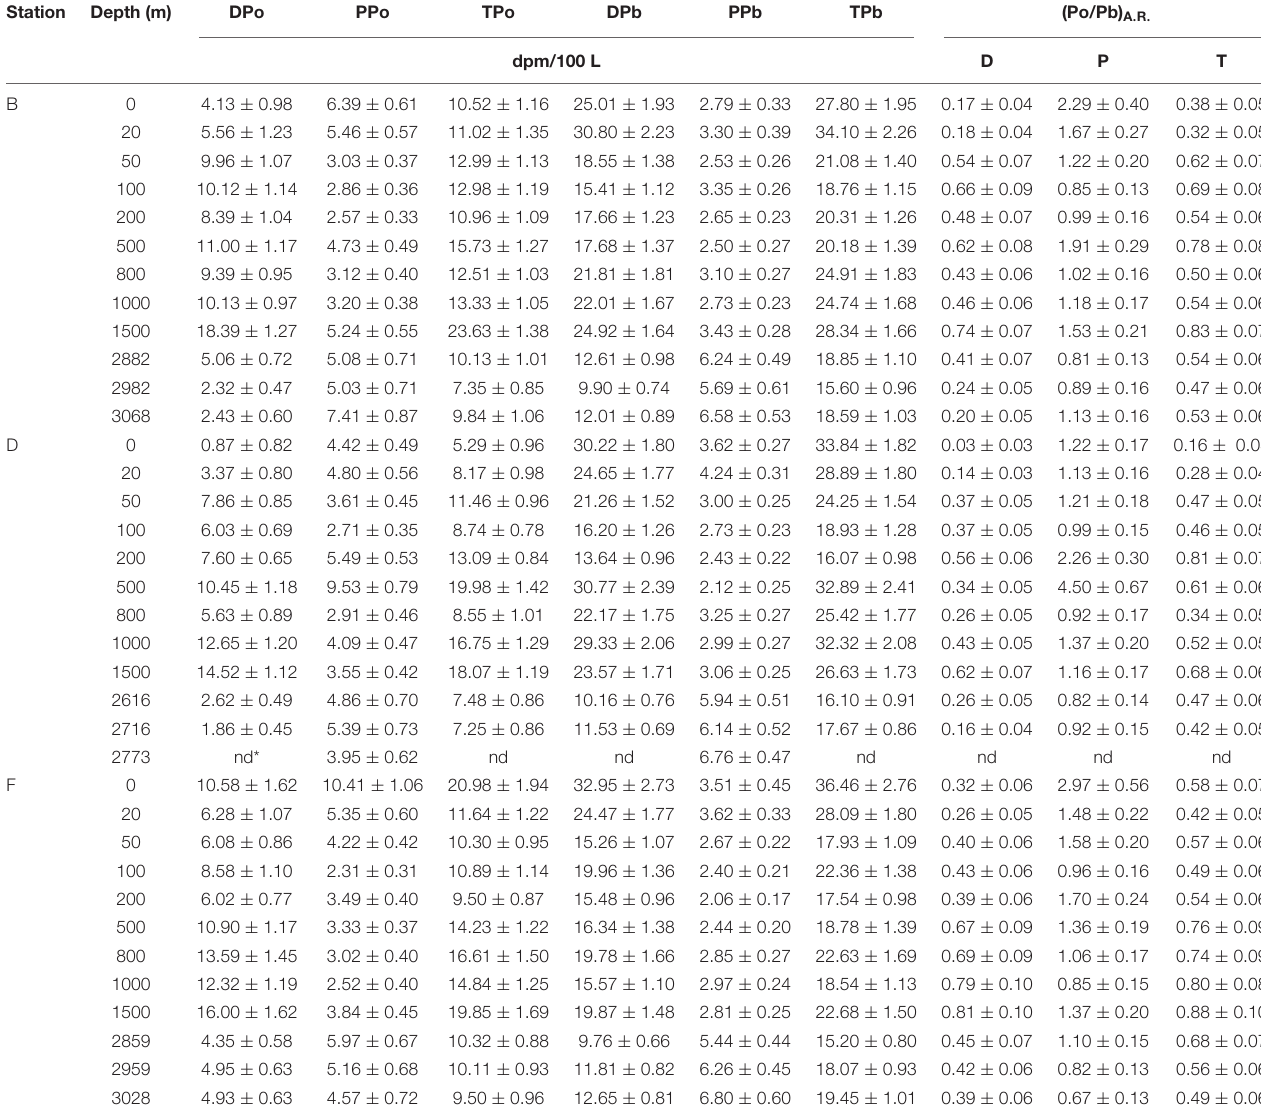
TABLE 2 | The specific activity of 210 Po and 210 Pb and activity ratio of 210 Po/ 210 Pb in the eastern tropical North Pacific. Station Depth